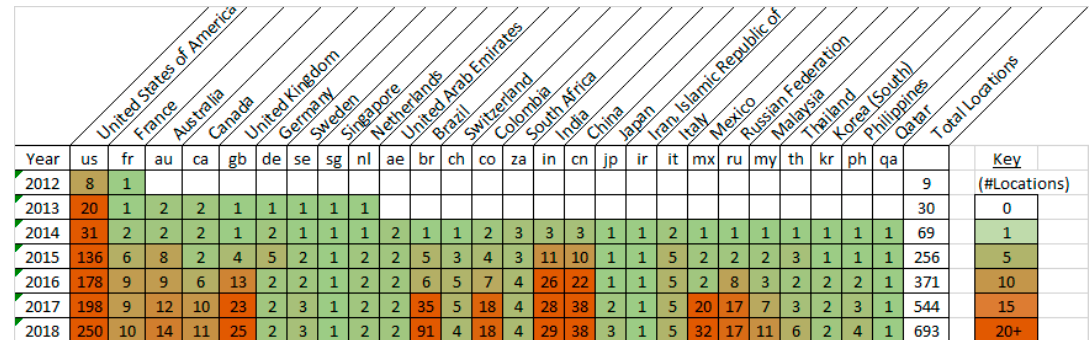
Figure 13. Global Apple Store openings 2006–2017 (World Mercator Projection).